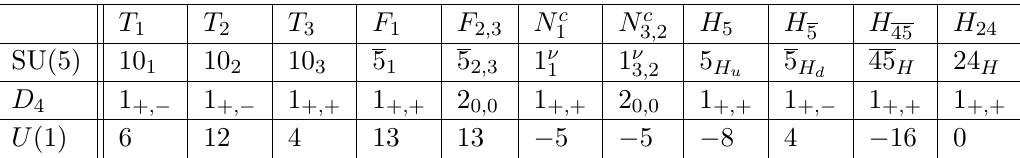
Table 1 . The SU(5) × D 4 representations and U(1) charges of the matter, RH neutrinos and Higgs superfields.